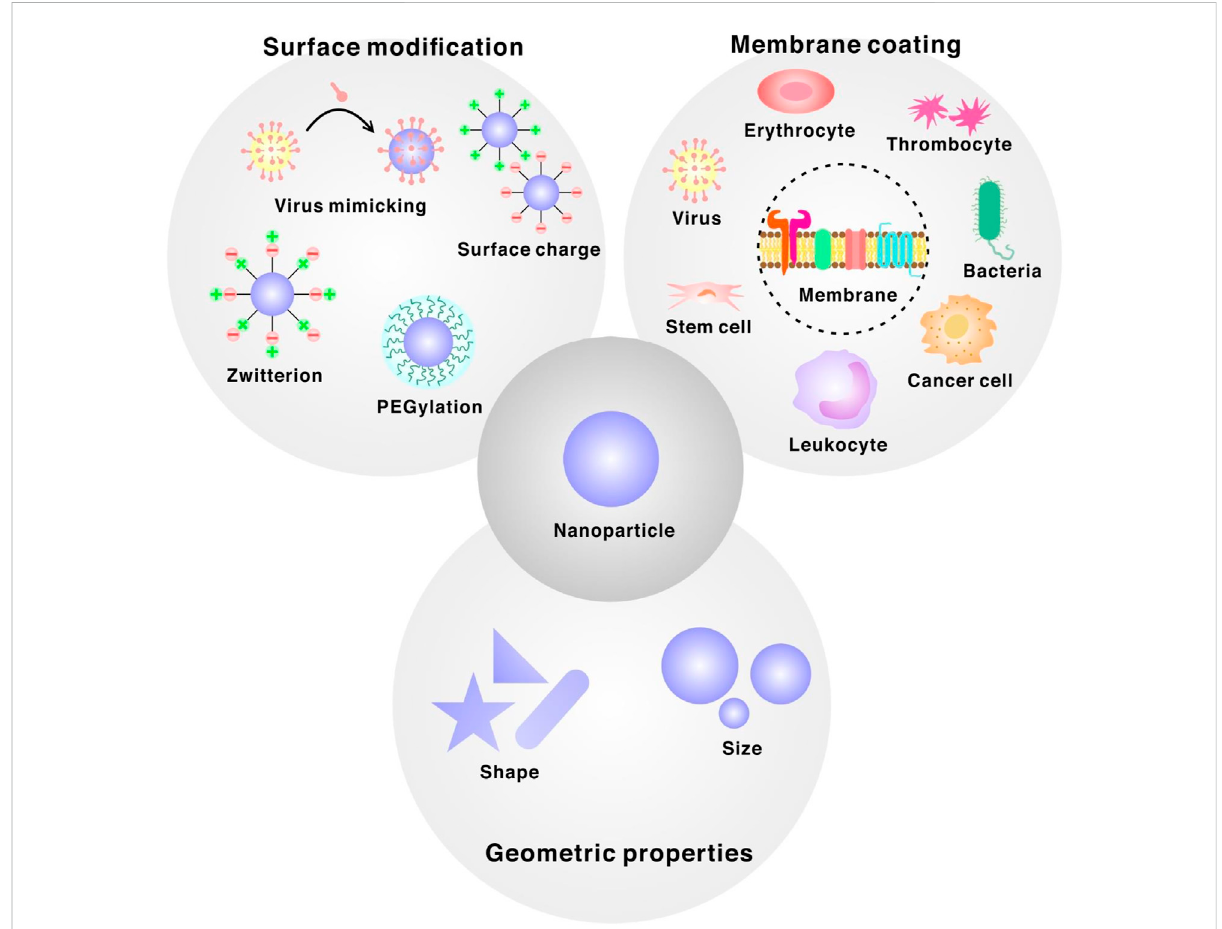
FIGURE 1 Design principles for bioinspired interfaces of nanoparticle categorized into three different sections. Membrane-coated nanoparticles derived frommammaliancell,cancercell,bacteriaorvirus.Surfacemodi fi cationligandssuchasPEG,zwitterion,positively/negativelychargedligandsorviral capsids. Manipulation of geometric properties of nanoparticles such as size or